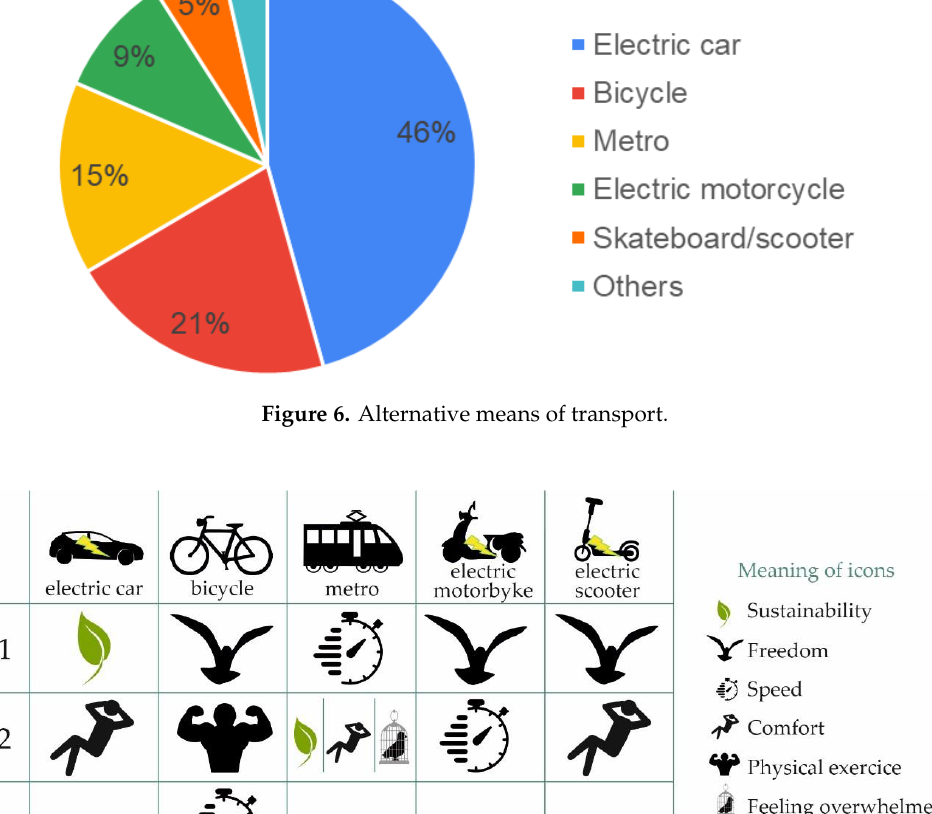
Figure 6. Alternative means of transport.